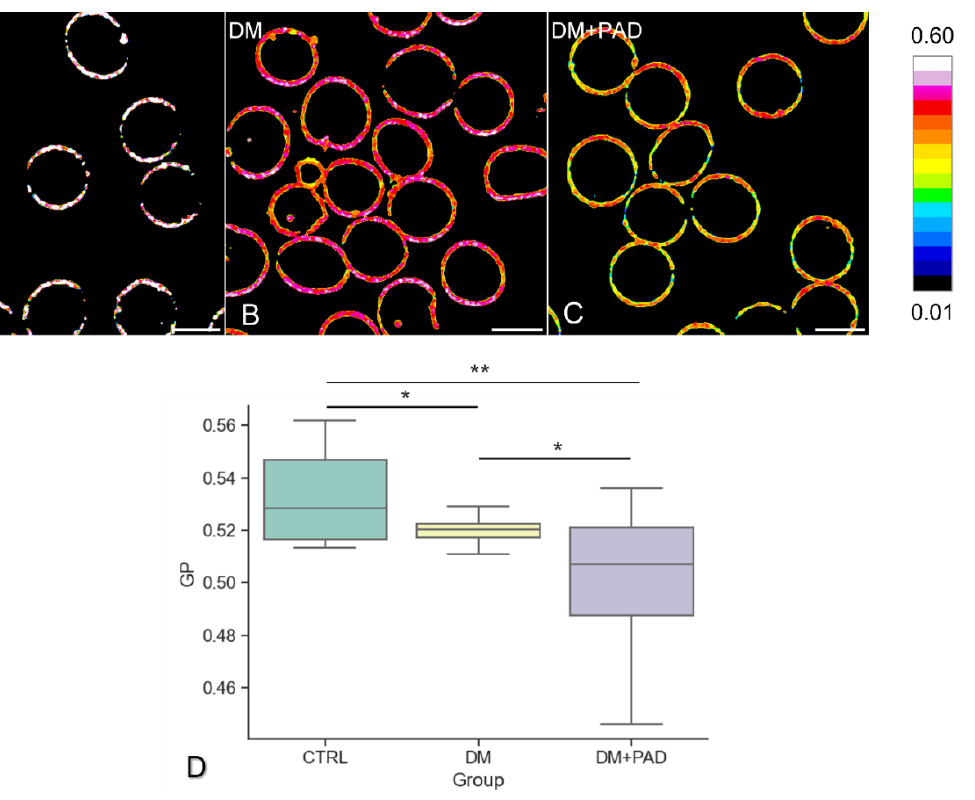
Figure 1. Representative fluidity maps and distribution of GP values for CTRL, DM, and DM+PAD RBC. In ( A – C ), each pixel’s color represents the Generalized Polarization (GP) values, which vary from white (low fluidity, high GP = 0.60) to blue (high fluidity, low GP = 0.01), according to the LUT bar reported along with the images. The preponderance of most LC (white and pink) domains is distinguishable in CTRL ( A ), and DM ( B ) RBC, whereas DM+PAD ( C ) patients are characterized by more fluid domains (colored in yellow and green). 5 images (about 100 RBC) were evaluated for each patient. Scale bar is 5 μm. The box plot in ( D ) shows the distribution of generalized polarization values calculated for each of the 37 subjects under study: CTRL (in green, on the left), DM (in yellow, in the middle) and DM+PAD (in purple, on the right). The three groups were statistically different for mean values of GP, according to Anova test followed by a post-hoc comparison ( p -adj = 0.03 for CTRL-DM; p -adj = 0.008 for CTRL-DM+PAD; p -adj = 0.04 for DM-DM+PAD). Holm method was used to adjust the p -value (** stands for p < 0.01; * stands for p < 0.05).